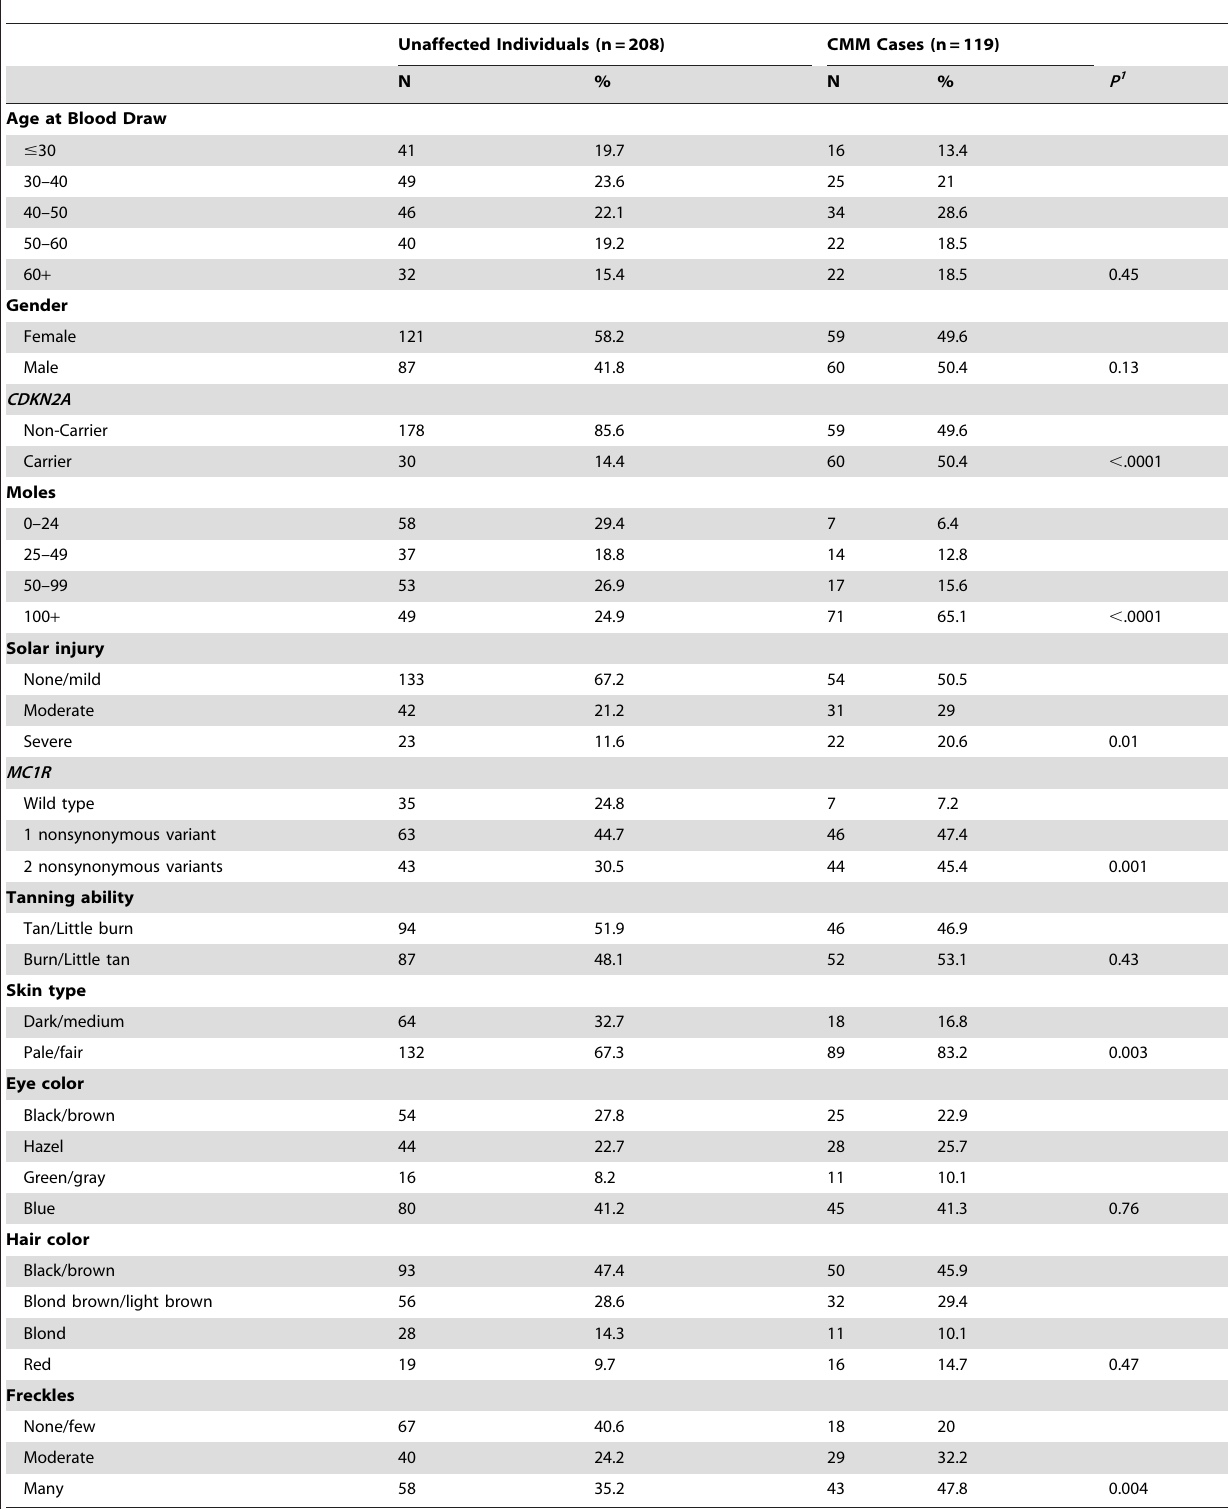
Table 1. Distribution of age, gender, CDKN2A , pigmentation phenotype, and sun exposure variables in 53 melanoma-prone families by CMM